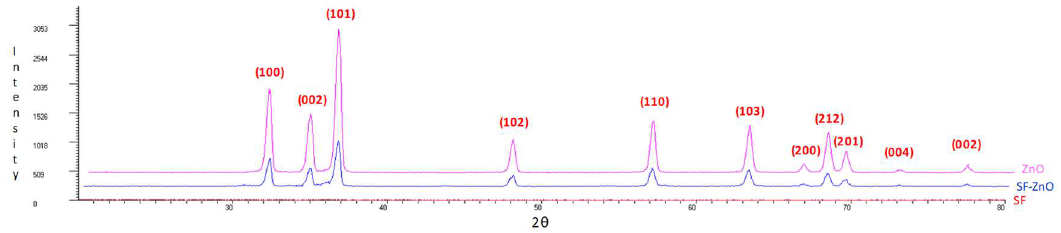
Figure 1. XRD patterns of SF/ZnO, SF, and ZnO.